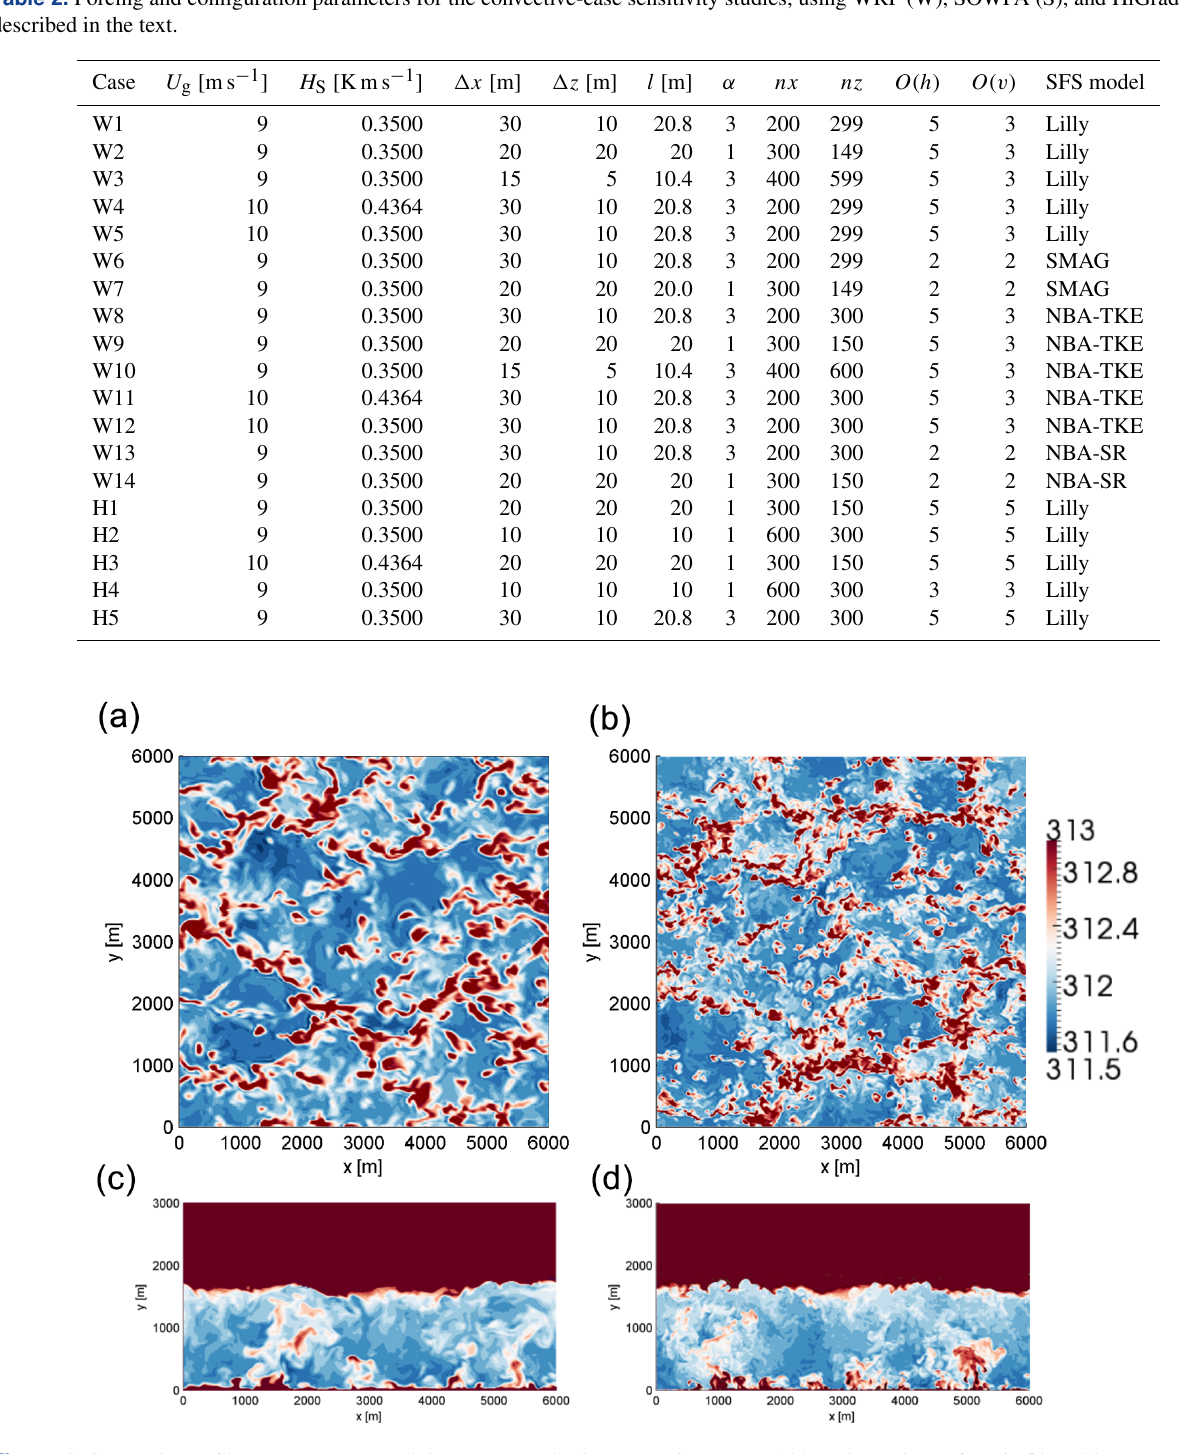
Figure 4. Comparison of instantaneous potential temperature in the convective case at 100m above the surface (a, b) and in a cross-stream plane midway through the domain (c, d) from the WRF solver operating at a 30m horizontal by 10m vertical resolution (a, c) and a 15m horizontal by 5m vertical resolution (b, d)